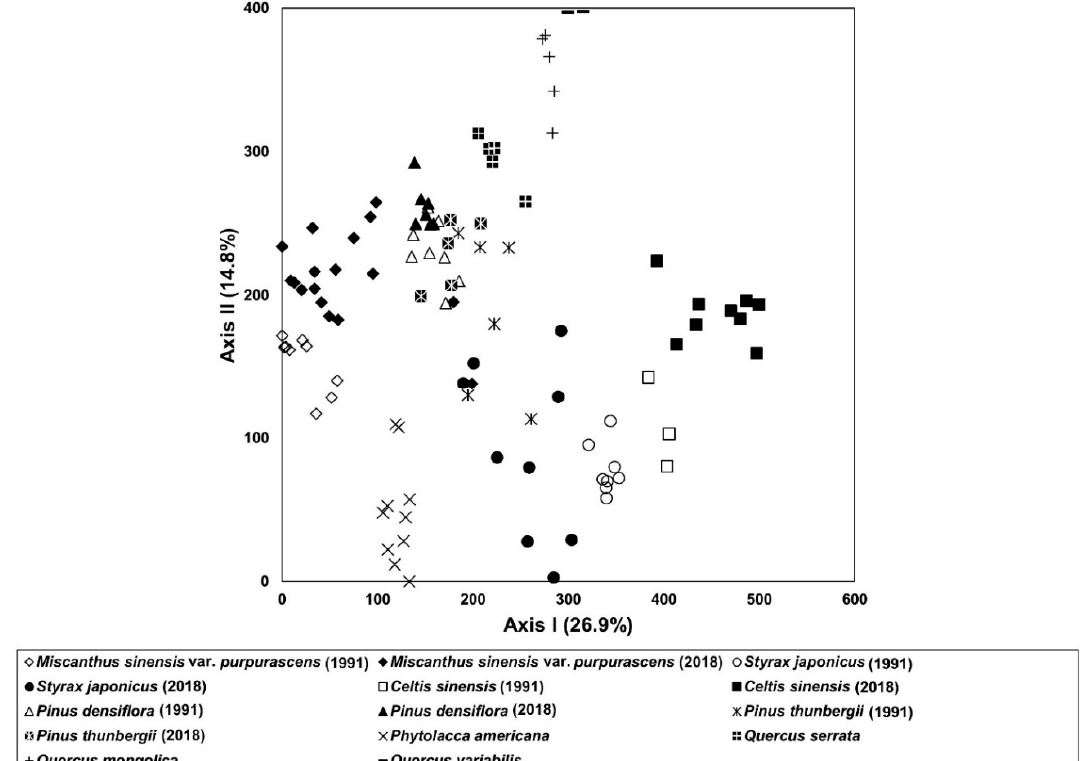
Figure 2. Ordination of plant communities established depending on the pollution degree around the Yeocheon industrial complex. 1991 and 2018 indicate the survey years. Vegetation types established in the inland area were arranged above the diagonal line that axis I and axis II form, whereas vegetation types established in the coastal area were below the line. On the other hand, the arrangements of vegetation types along the axis I reflect their successional stages. Synthesized those results, axis I and axis II indicate the degree of pollution and vegetation degradation due to the distance from the pollution source and the distance from the coastal area, respectively.